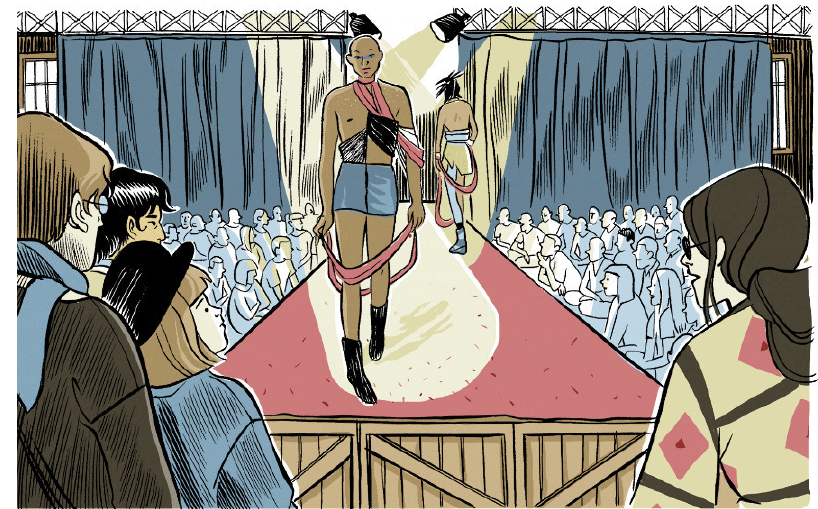
Figure 7: Blurring Lines between Beauty and Ugliness in High